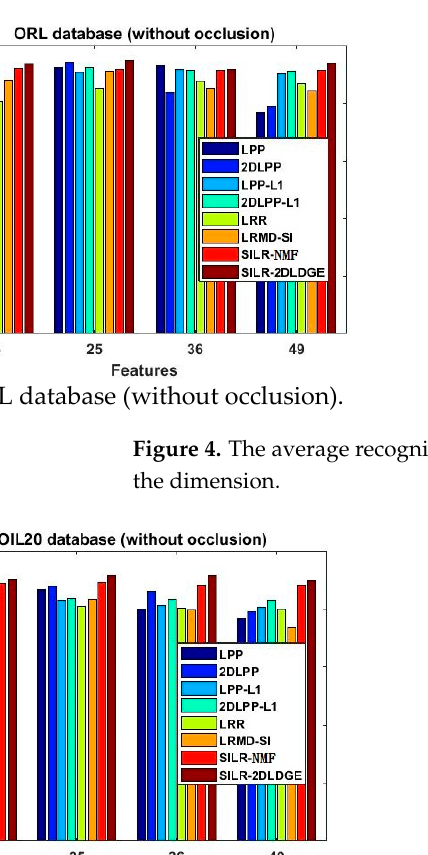
Figure 3. The average recognition rates (%) of the eight algorithms in the FERET database vary with the dimension.